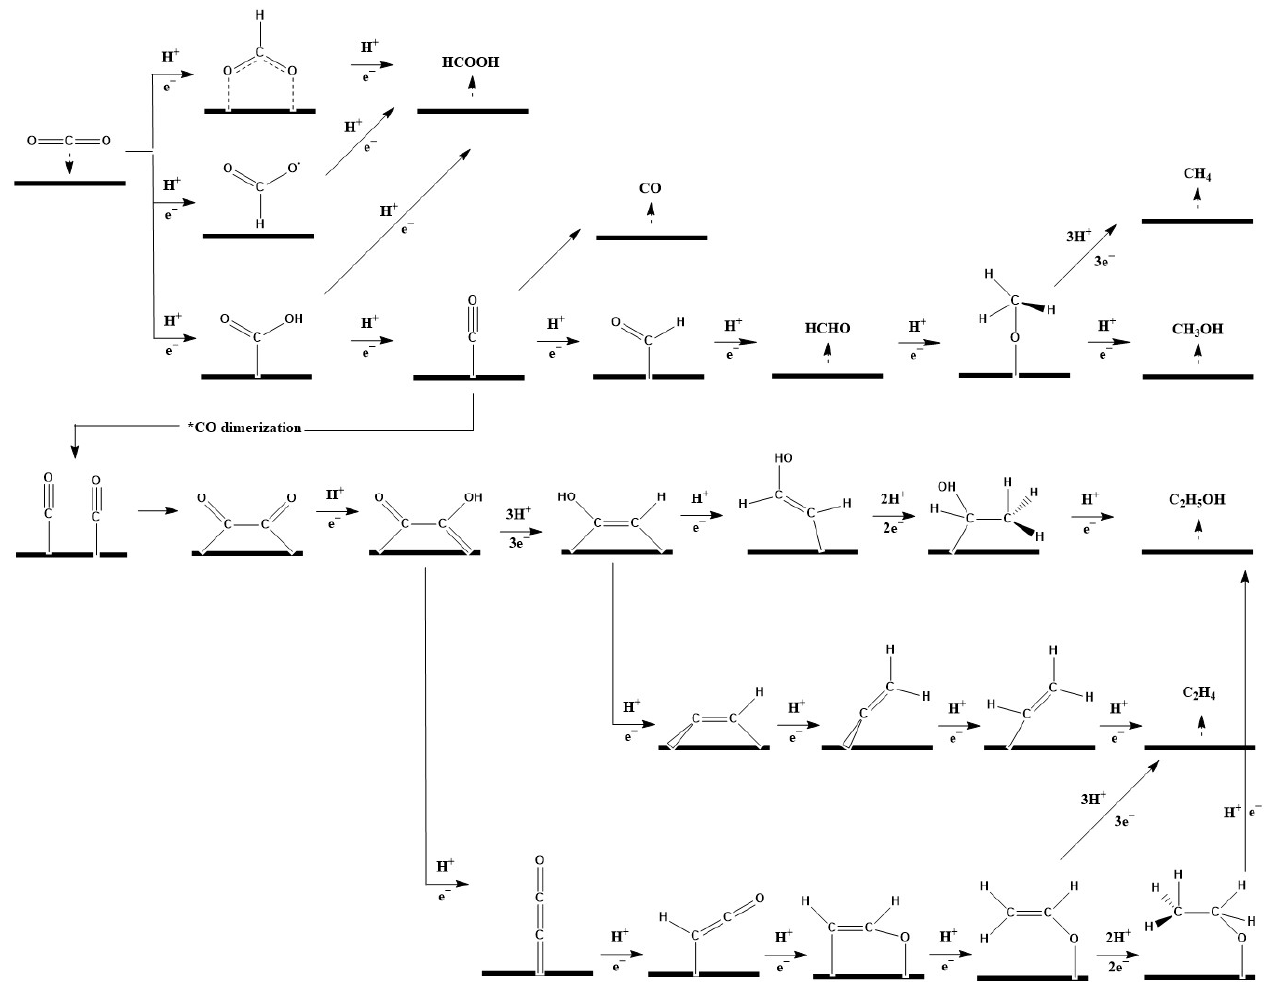
Figure 1. Proposed reaction routes for CO 2 electroreduction to various products such as CO, HCOOH, CH 4 , CH 3 OH, C 2 H 4 , and C 2 H 5 OH [18,24–28].